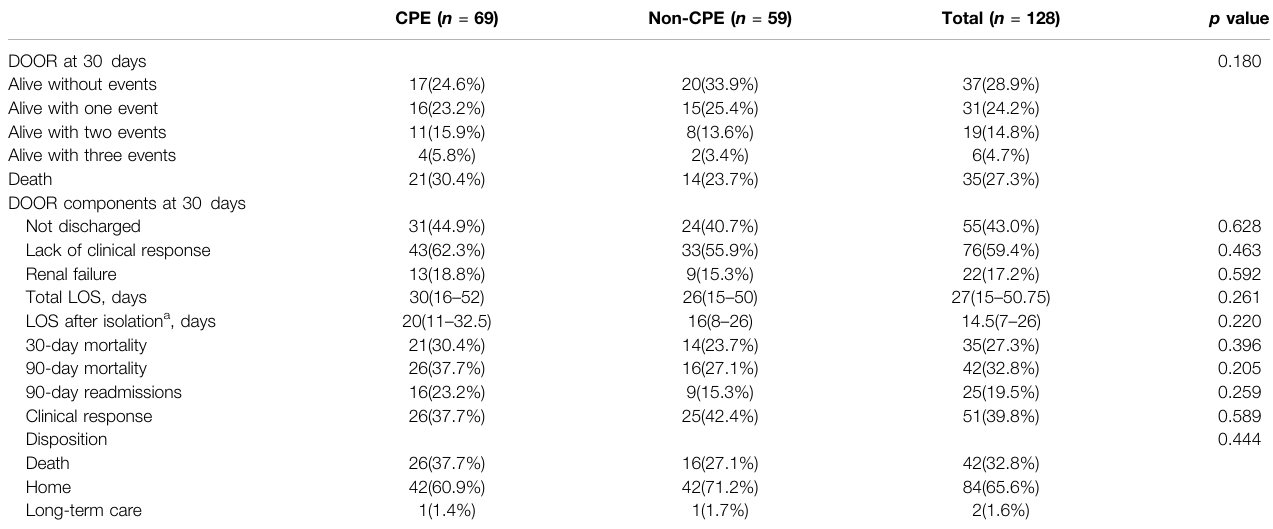
TABLE 5 | Outcomes in patients with CRE